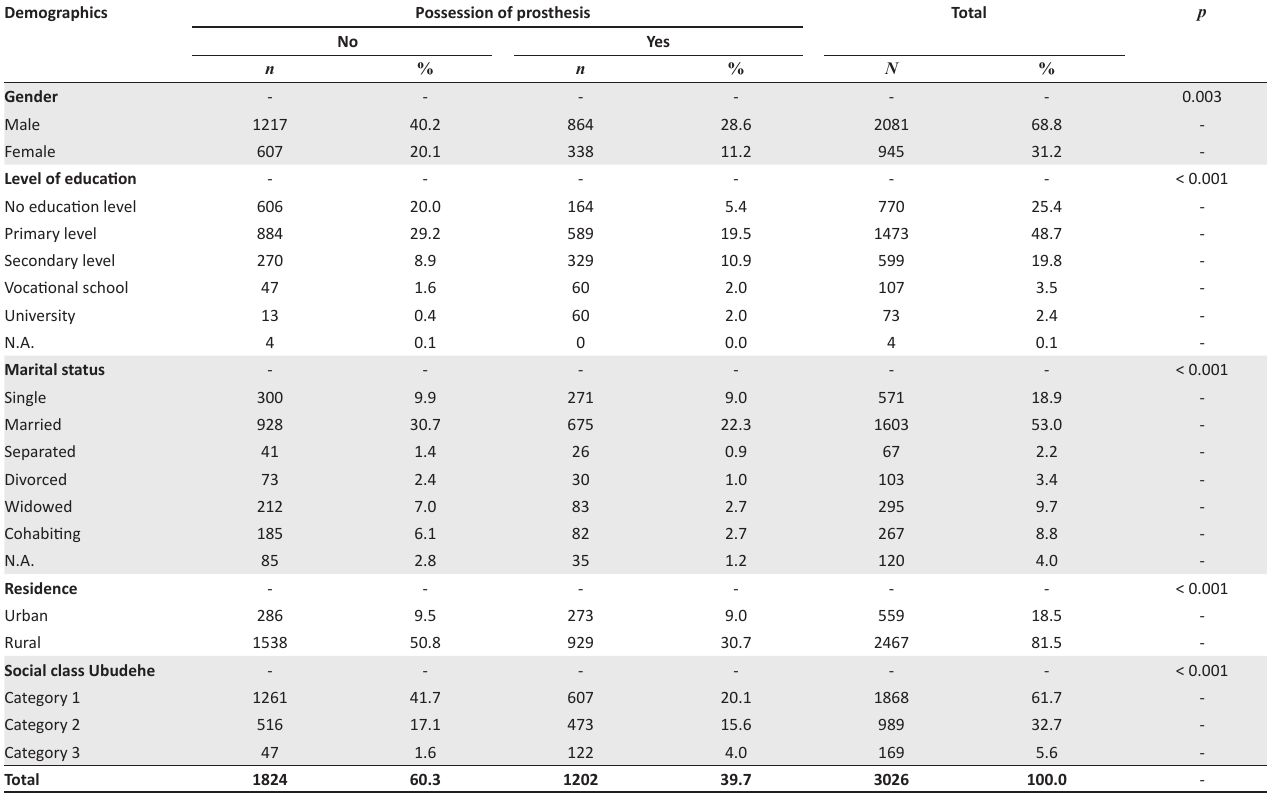
TABLE 1: Socio-demographic characteristics of participants.